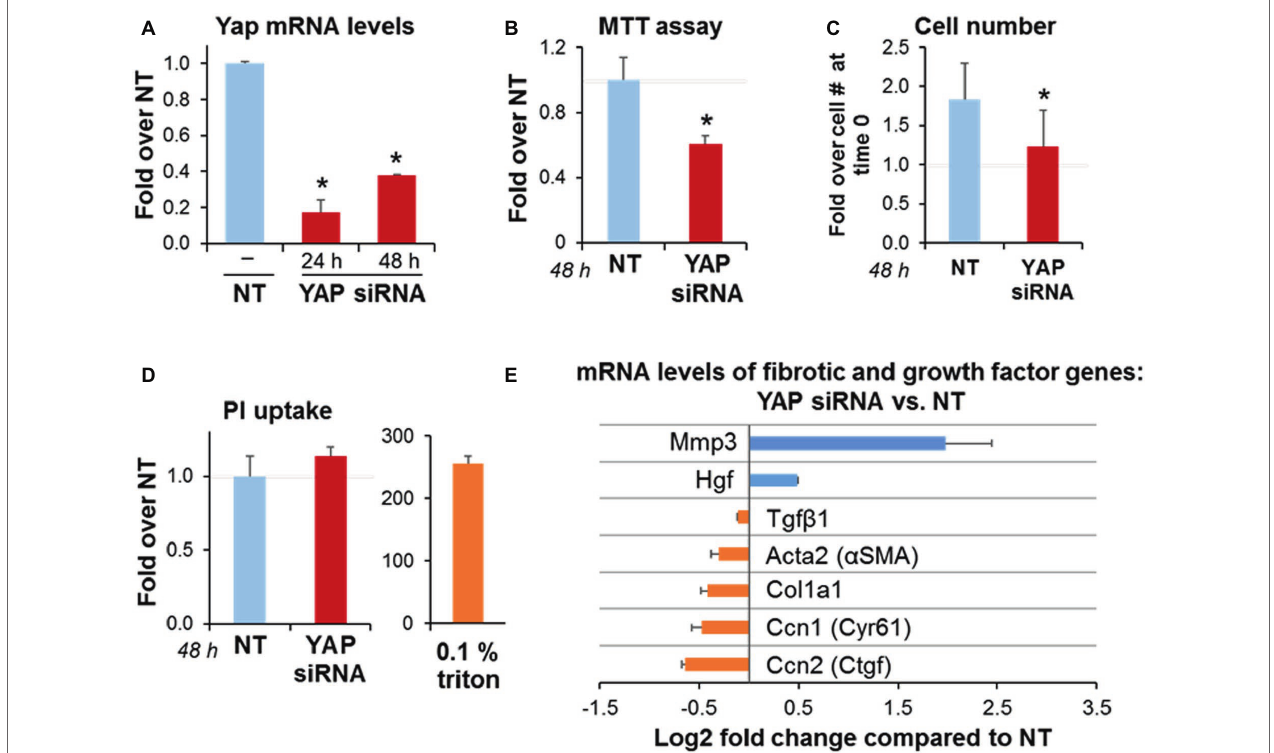
FIGURE 4 | YAP siRNA decreases PaSC expansion in culture and alters expression of genes involved in matrix remodeling. imPaSC were transfected with nontargeting negative control ( NT , 10 nmol/L) or a target siRNA ( YAP , 10 nmol/L) mixed with lipofectamine RNAiMAX, and 24 h later cells were used for experiments. (A) Graph shows quantitation of YAP mRNA expression relative to negative control at 48 h post-transfection. Data are mean ± SD, n = 3; * p < 0.05 vs. NT. (B) MTT assay for YAP siRNA-treated cells relative to NT. (C) The graph shows imPaSC numbers counted 0 and 48 h after treatment with either NT or YAP siRNA. The cell numbers were assessed by trypan blue exclusion using a hemocytometer, and expressed as a fold increase over time 0 (1.5 × 10 5 ). (D) PI uptake was measured in cells treated with siRNA to detect any disrupted plasma membrane integrity. After incubation, a portion of cells was permeabilized for 5 min with 0.1% Triton X100 to establish a positive control. Data in graphs (B–D) are mean ± SD, n = 3–6 independent experiments; * p < 0.05 vs. NT. Supplementary Figure S2B shows protein levels of caspase-3 as a marker of caspase-dependent apoptosis . (E) Graph shows mRNA levels of the indicated genes in YAP siRNA treated cells compared to NT. Data is mean ± SD, n =